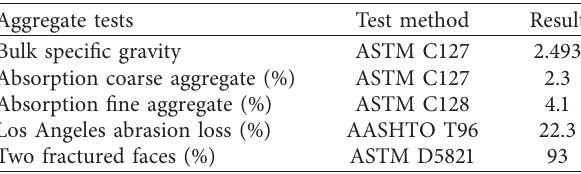
Figure 1: Flowchart of the research approach. Table 1: Physical properties of aggregates.